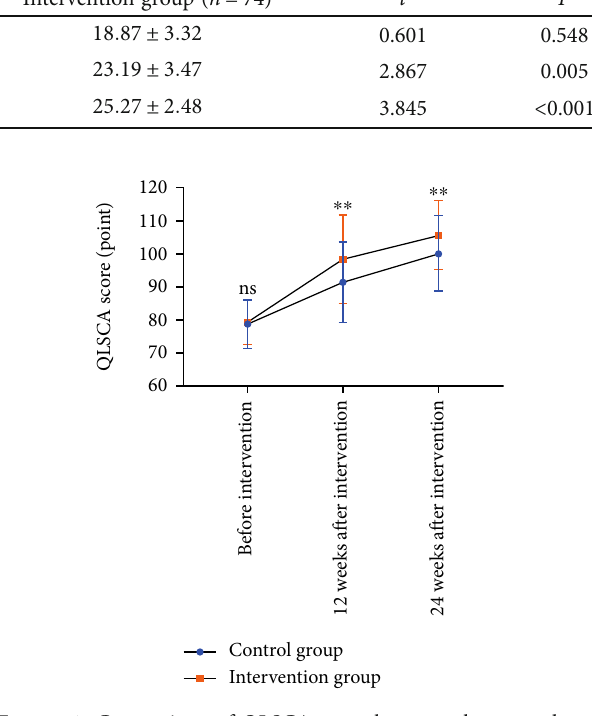
Figure 1: Comparison of QLSCA score between the control